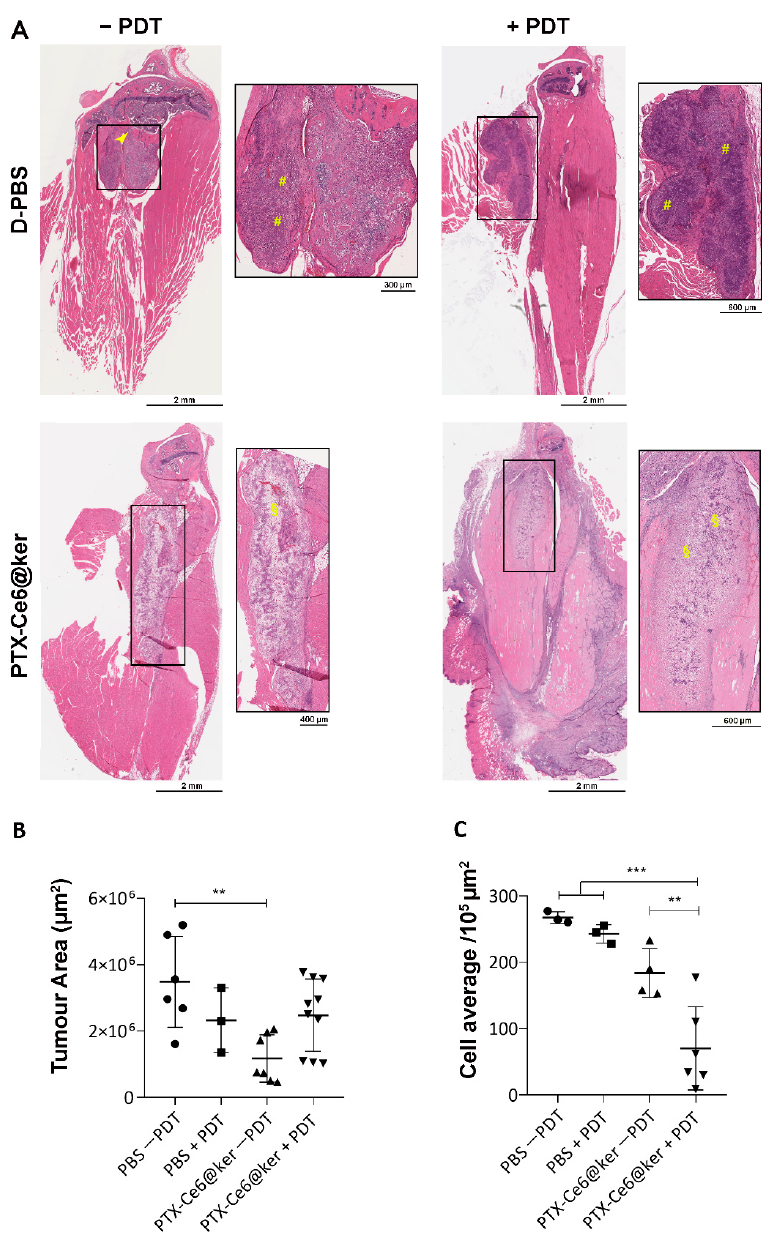
Figure 6. Preclinical evaluation of the therapy efficacy. ( A ) Representative H&E stained paraffin sections from tibia explants of animals from control groups (D-PBS − /+ PDT) and treatment groups (PTX-Ce6@ker − /+ PDT). Magnification of the black squared area is shown on the right side of the main panels. ( B , C ) The graphs show the quantification of tumor area and tumor cell number, respectively, performed with QuPath software. Data are expressed as the mean ± SD and analyzed using the One-way ANOVA test, and Tukey’s multiple comparison test as a post-test. Results were statistically significant at p values < 0.05 (** p -values< 0.01; *** p -values <